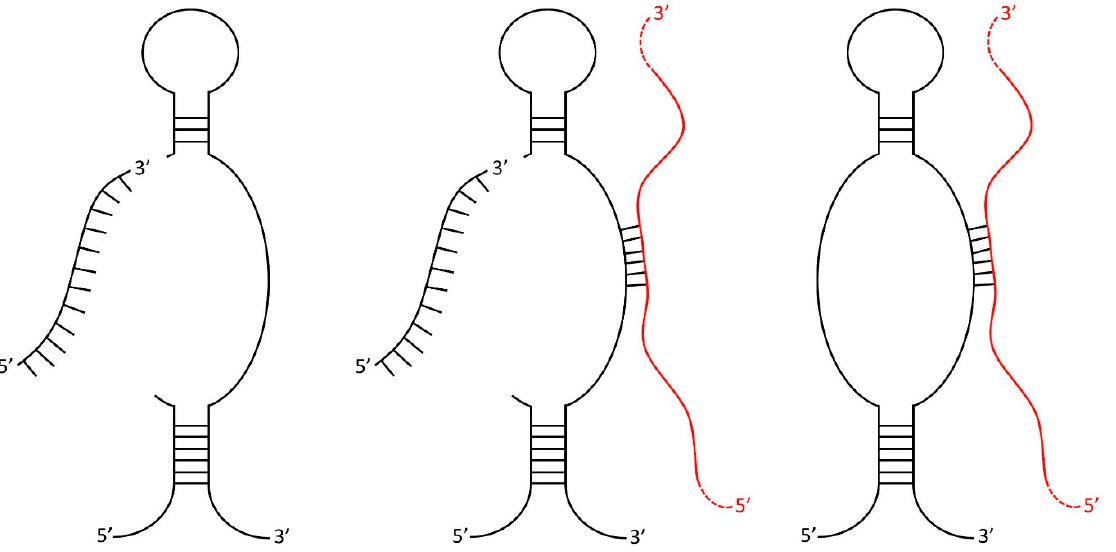
Figure 1. SdRNAs are specifically processed from annotated snoRNA loci. Transcripts arising from various annotated snoRNA loci have now been definitively shown to participate in at least two distinct noncoding RNA regulatory pathways. Individual loci can produce snoRNAs functioning exclusively as traditional posttranscriptional RNA editors directing 2 (cid:48) -O-methylation or pseudouridylation of transcripts ( right ), or exclusively as functional miRNA precursors ( left ). Some loci have now been confirmed to produce transcripts, at times engaging in both types of noncoding RNA regulation ( center ). MiRNA-like excision products are illustrated in black ( left and center ) as excision products of primary transcript. Complementary RNA editing targets are shown in red ( right and center ) with red dashes indicating the larger transcript excluded for the purpose of clarity. Adapted from Patterson et al.